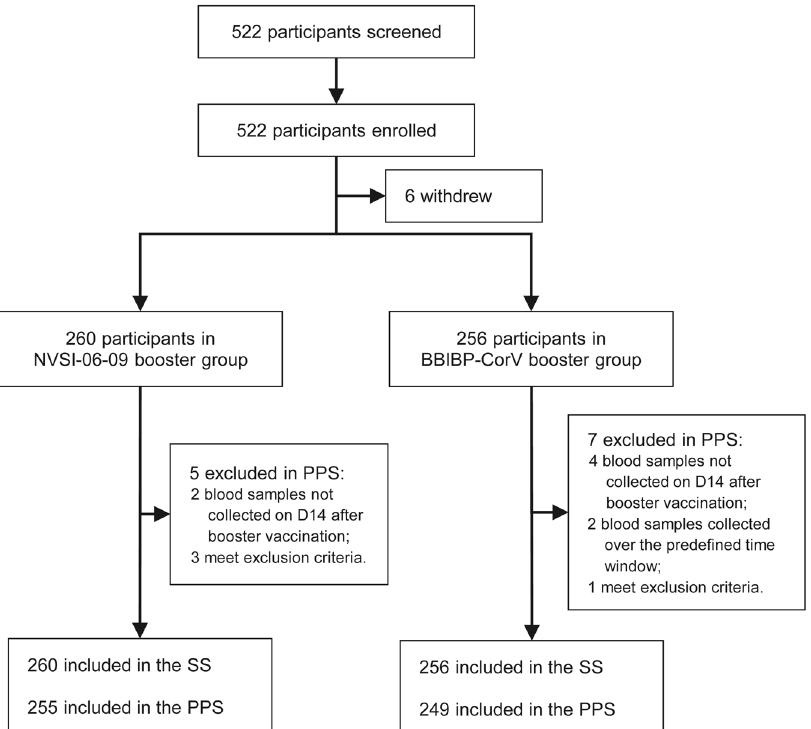
Fig. 1 Screening, randomization, and analysis populations. 522 healthy adults were screened and enrolled, of which 6 persons withdrew before vaccination and 516 participated in the study. The participants were randomly assigned to receive a booster injection of either NVSI-06- 09 (260 participants) or BBIBP-CorV (256 participants). All these participants that received the booster vaccination were contained in the safety set (SS) for the analysis of vaccine safety. 255 participants in NVSI-06-09 booster group and 249 in BBIBP-CorV booster group who had valid immunogenicity data were included in the per-protocol set (PPS) for the analysis of vaccine